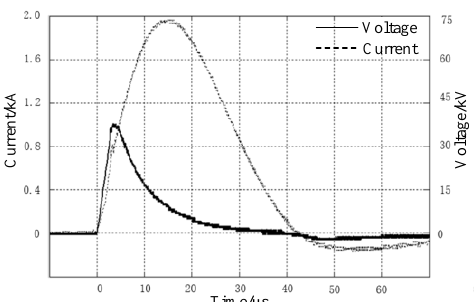
Figure 12. Current and voltage waveform of soil without SAP when injected into the impulse current.